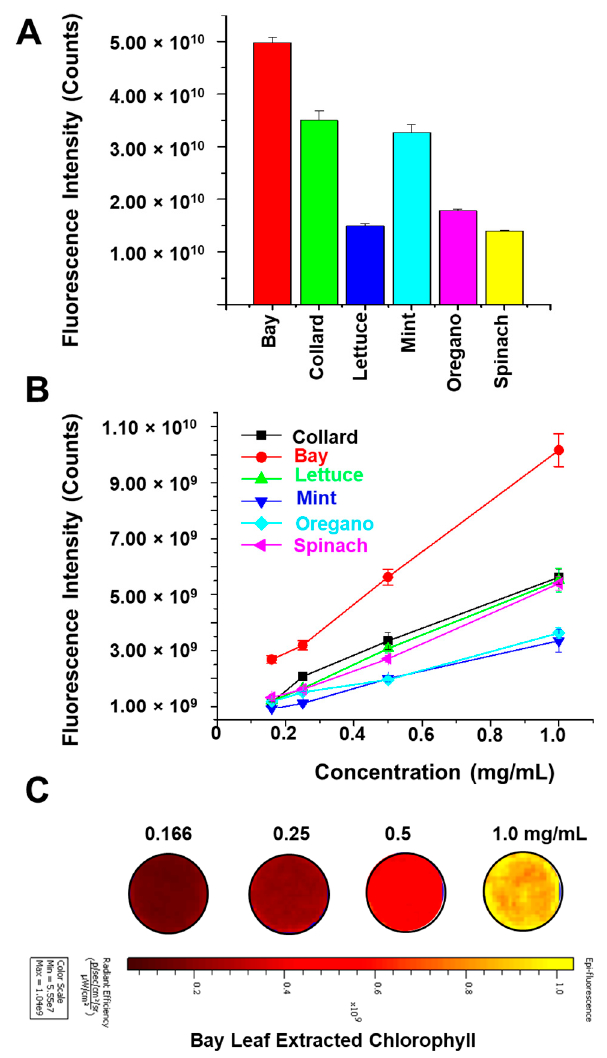
Figure 2. Fluorescence measurement of top six leaf extracts. ( A ) Based upon whole leaf imaging data, six most fluorescent leaves were selected for further imaging experiments. Bar graph represents chlorophyll fluorescent intensity. Bay leaf exhibited the highest fluorescence levels. ( B ) Chlorophyll dye was extracted using EtOH from these leaves. Different dilutions of extracted chlorophyll were prepared and a 5 μ L drop was imaged. Line graph represents the average fluorescent intensity of extracted chlorophyll dye at different dilutions from three individual experiments. n = 3. ( C ) Images represent bay leaf extracted chlorophyll concentrations.